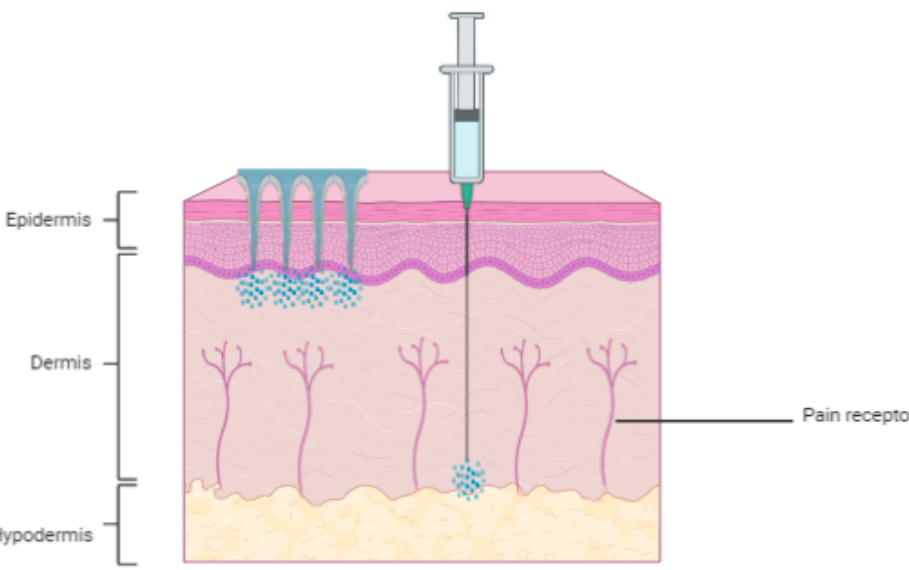
Figure 1. Drug dosing utilizing microneedle tools compared with a hypodermic needle.